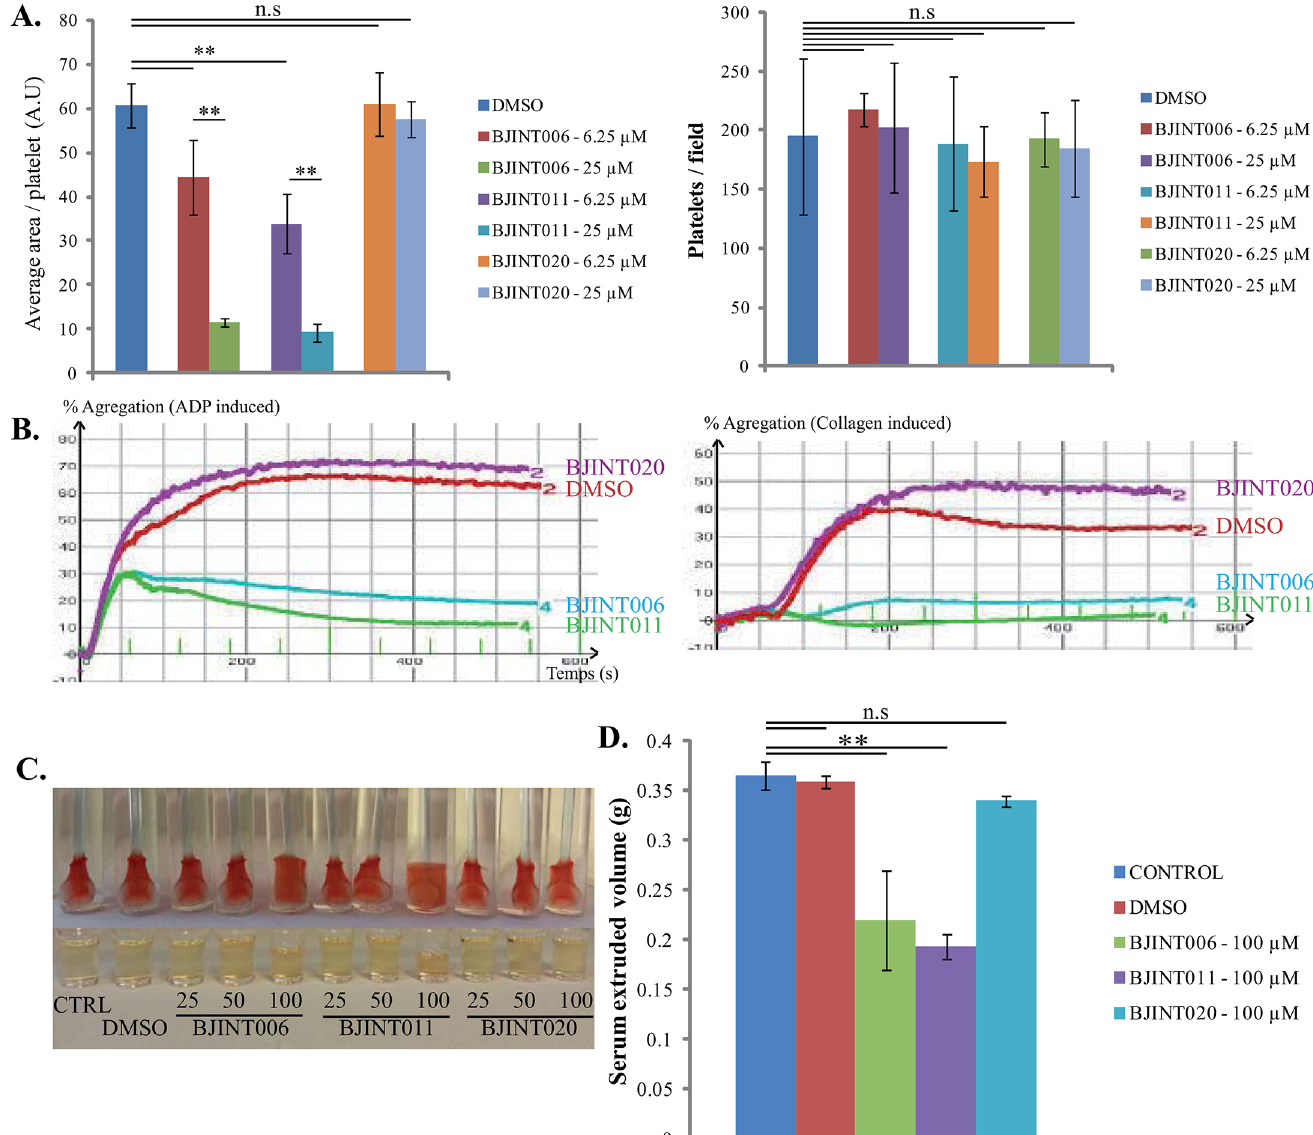
Fig 4. BJINT006 and 011 inhibit α IIb β 3 mediated platelet activation related processes. (A) Platelet adhesion and spreading on collagen were carried out as described under Materials and Methods. Quantification of spreading and adhesion upon BJINT006, 011, and 020 treatments is shown on left and right panels, respectively. (B) Collagen- and ADP -induced aggregation kinetics are shown. Aggregation assays are carried out in the presence or absence of BJINT derivatives (50 μ M). (C) Clot retraction is induced by thrombin addition to PRP as described under Materials and Methods. BJINT006, 011 but not BJINT020, prevents proper clot retraction at the concentration of 100 μ M. (D) The extruded serum volume was measured 10 minutes after thrombin addition to quantify clot